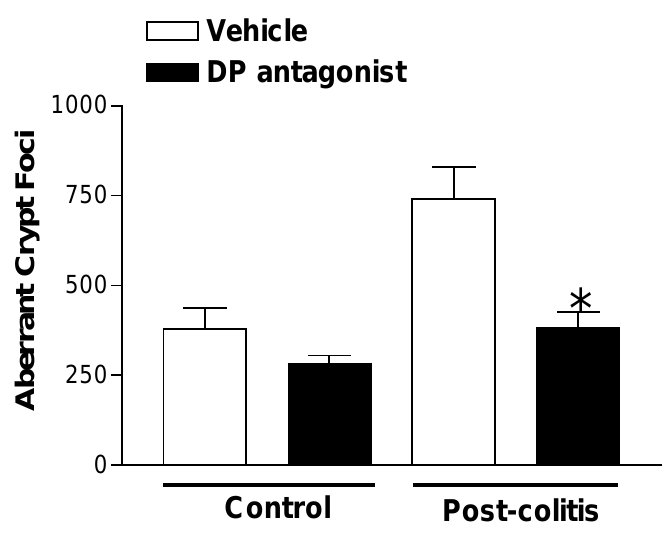
FIGURE 6. Colitis-associated preneoplastic lesions in the colon (ACF) are prevented by treatment for 1 week with a PGD 2 receptor antagonist (BW A868c). Note that postcolitis rats develop more ACF than control (healthy) rats given the same carcinogen. * p < 0.05 vs. the corresponding vehicle-treated group. Further details of these experiments can be found in Zamuner et